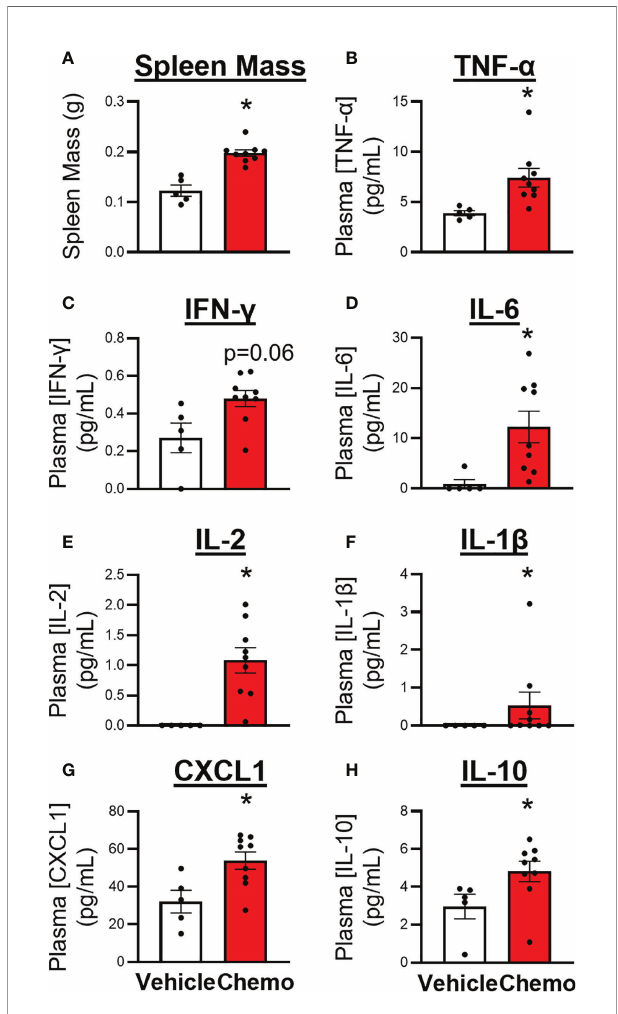
FIGURE 4 | Paclitaxel chemotherapy increased circulating in fl ammatory markers following the fi nal dose in survivor mice. (A) Spleen mass, plasma levels of pro- and anti- in fl ammatory cytokines, (B) TNF a , (C) IFN g , (D) IL-6, (E) IL-2, (F) IL – 1 b , (G) CXCL1, and (H) IL-10. Paclitaxel n=9, vehicle n=5. Unpaired parametric two-tailed t tests were used for statistical analyses. Nonparametric Mann-Whitney U tests were used when the assumptions of normality and equal variances were not met.